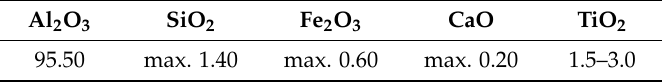
Table 3. Chemical composition of corundum in wt. %.